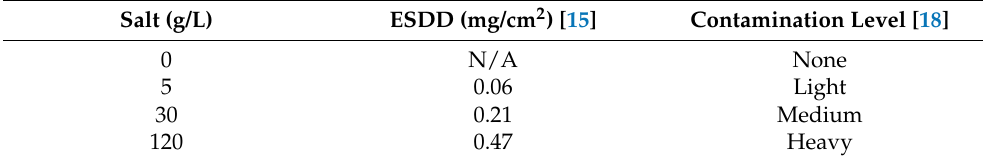
Table 4. Artificial